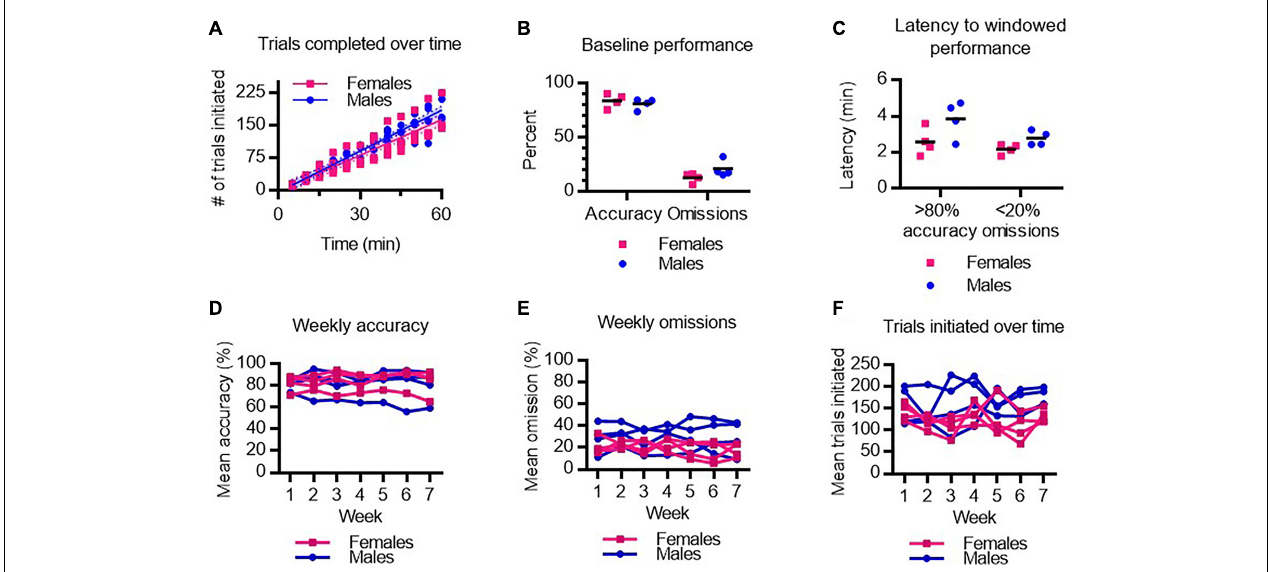
FIGURE 2 | Baseline performance on the 5-CSRTT in male and female rats. (A) Number of trials completed by male and female rats following training. (B) Average accuracy and omission performance prior to anesthesia testing in male and female rats. (C) The latency to achieve 4 out of 5 correct responses ( > 80% windowed accuracy) and to achieve 1 or fewer omissions out of 5 trials ( < 20% windowed omissions) at baseline in male and female rats. (D–F) Mean accuracy (D) , omissions (E) , and trials initiated (F) , over 7 weeks of testing was stable across male and female rats. N =